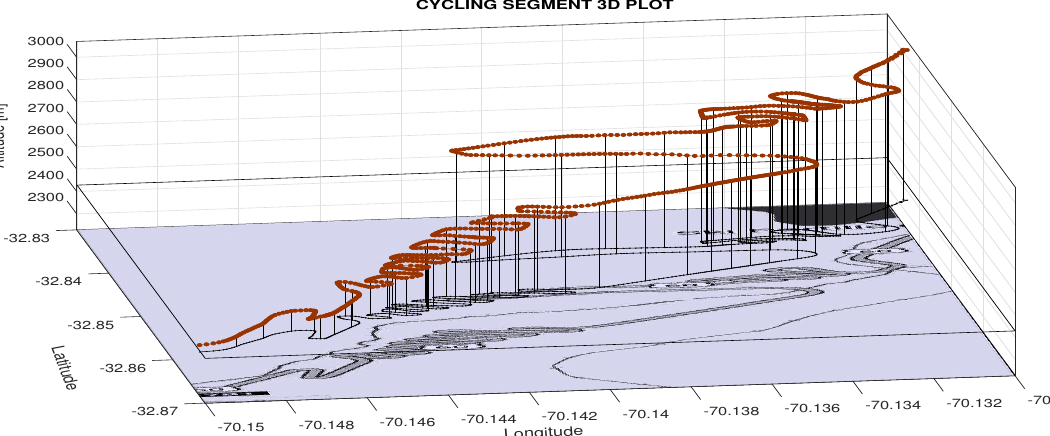
Figure 2. Detailed part of the cycling expedition across the Andes mountains (10 km long), recorded for 28 min of downhill cycling with an average speed of 22